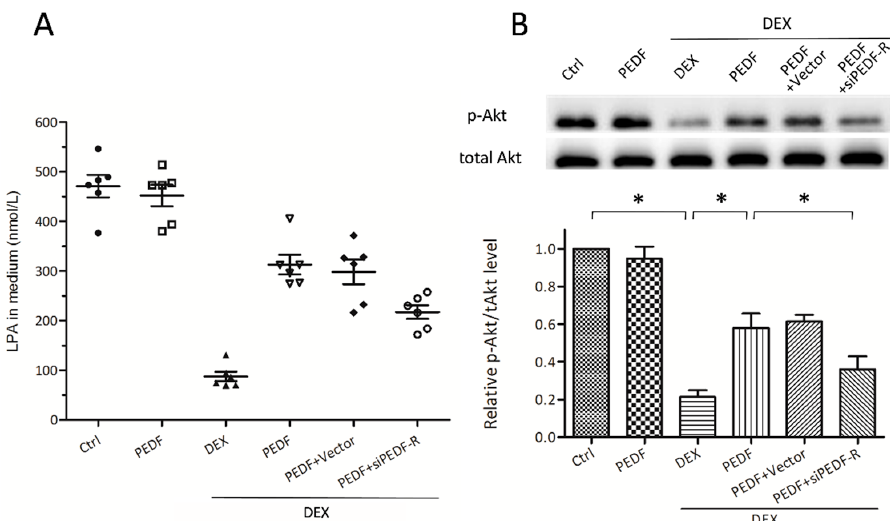
Figure 5. PEDF-R mediated PEDF activates PI3K/Akt pathway by increasing LPA levels in MC3T3-E1 pre-osteoblasts. MC3T3-E1 pre-osteoblasts treated with or without rPEDF were exposed to 10 − 5 M DEX for 24 h. RNA interference assays were performed to silence PEDF-R. ( A ) LPA levels in the medium were tested by ELISA, with results normalized to the corresponding protein concentration ( n = 6, * p < 0.05); ( B ) pAkt (phosphorylated Akt) and tAkt (total Akt) amounts were detected by Western blot. The ratio of pAkt/tAkt were expressed as fold induction ( n = 5, * p < 0.05), relative to control. Data are mean ± SD.